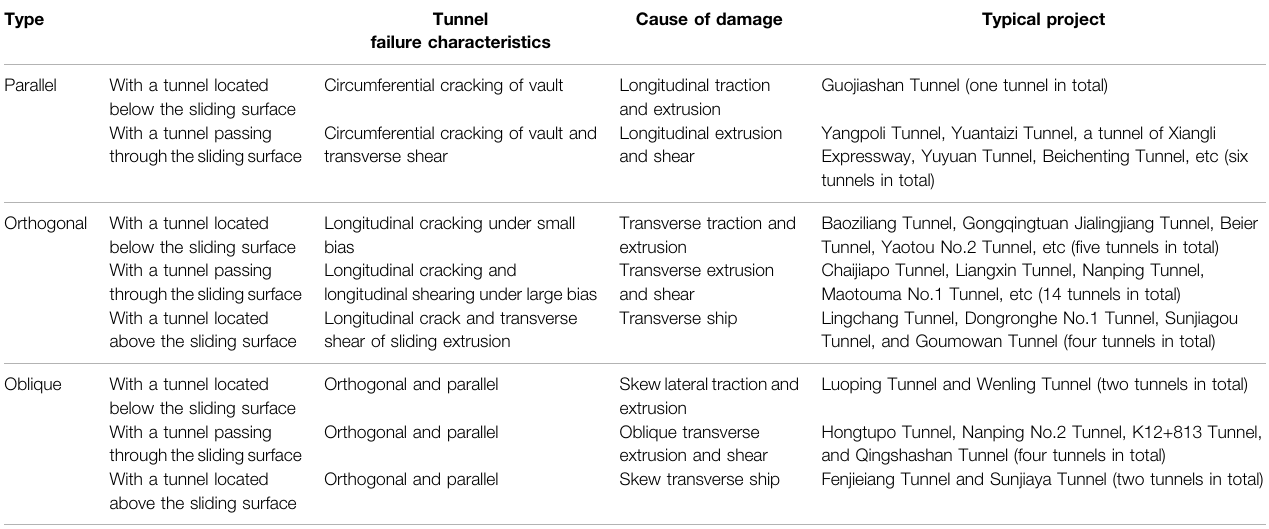
TABLE 1 | Types of tunnel-related landslides and tunnel failure characteristics.